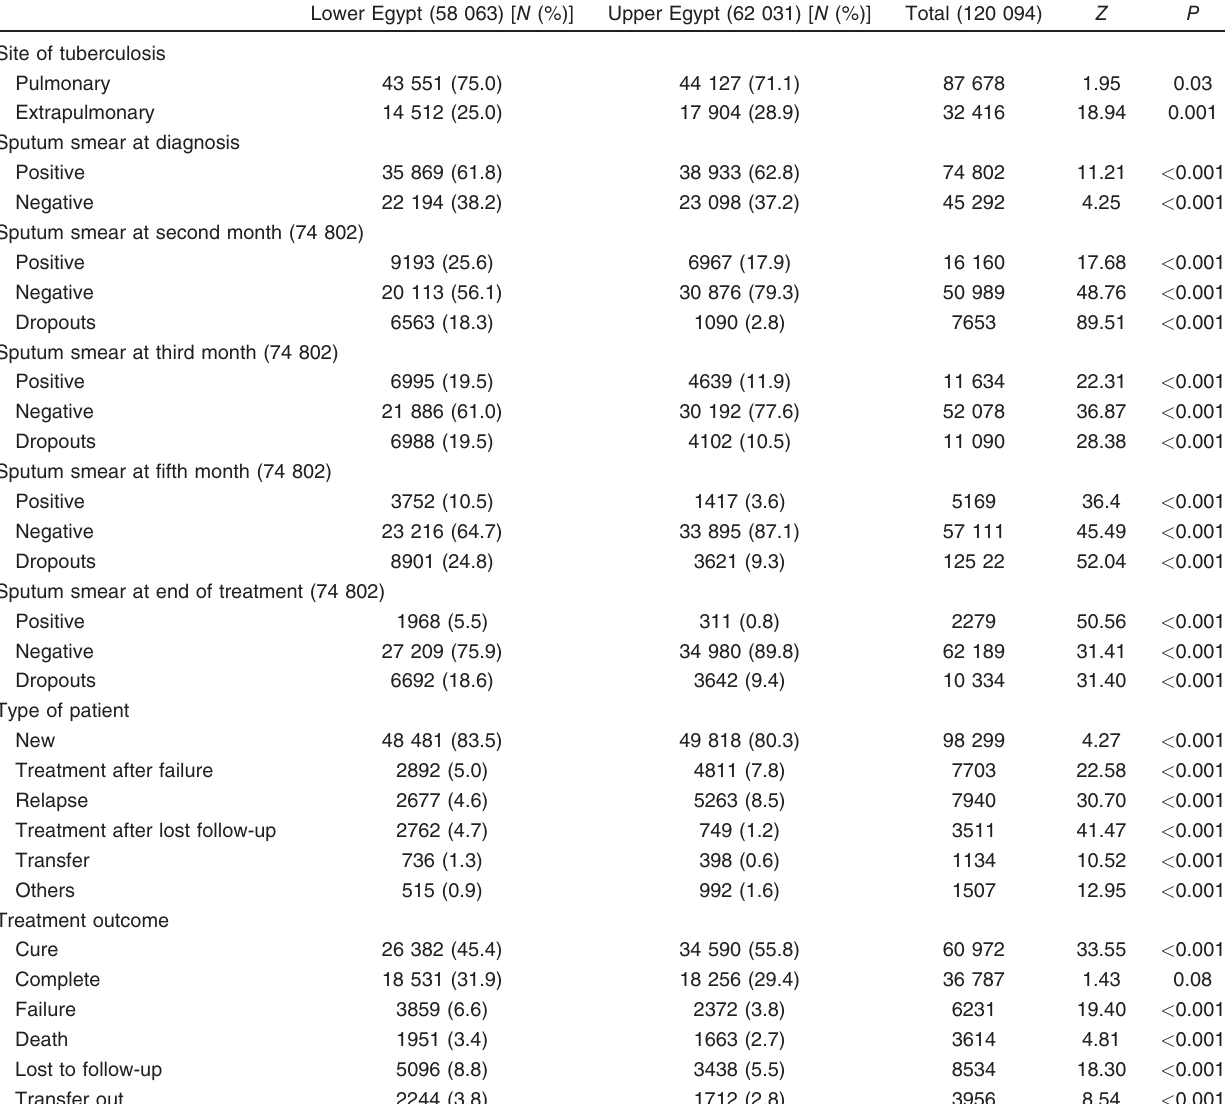
Table 3 Comparison between tuberculosis disease criteria in Lower Egypt and Upper Egypt Lower Egypt (58 063) [ N (%)] Upper Egypt (62 031) [ N (%)] Z P Site of tuberculosis